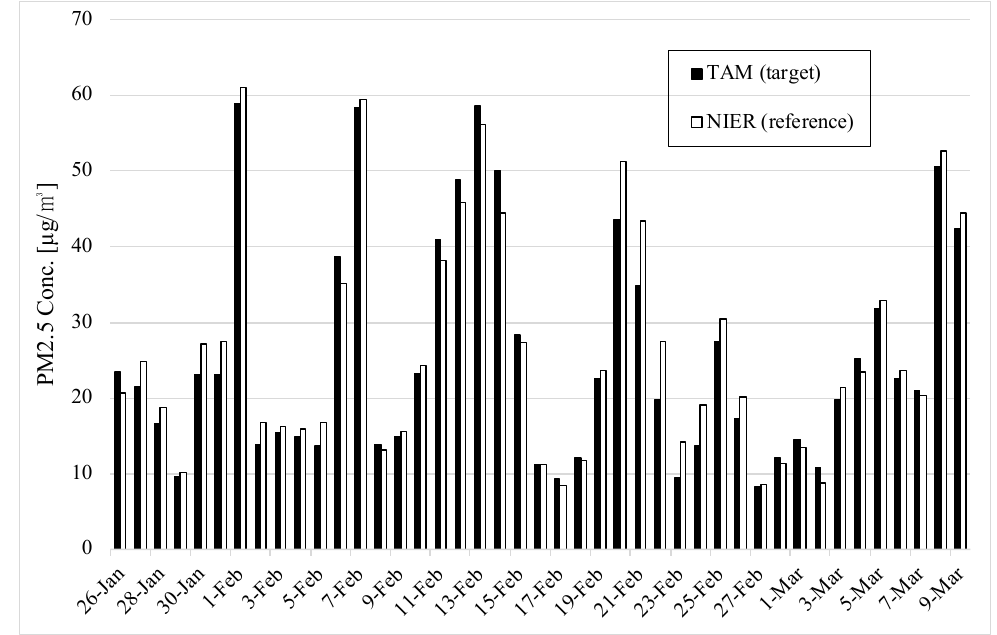
Figure 13. PM concentrations of TAM and NIER on daily average from 26 January to 9 March